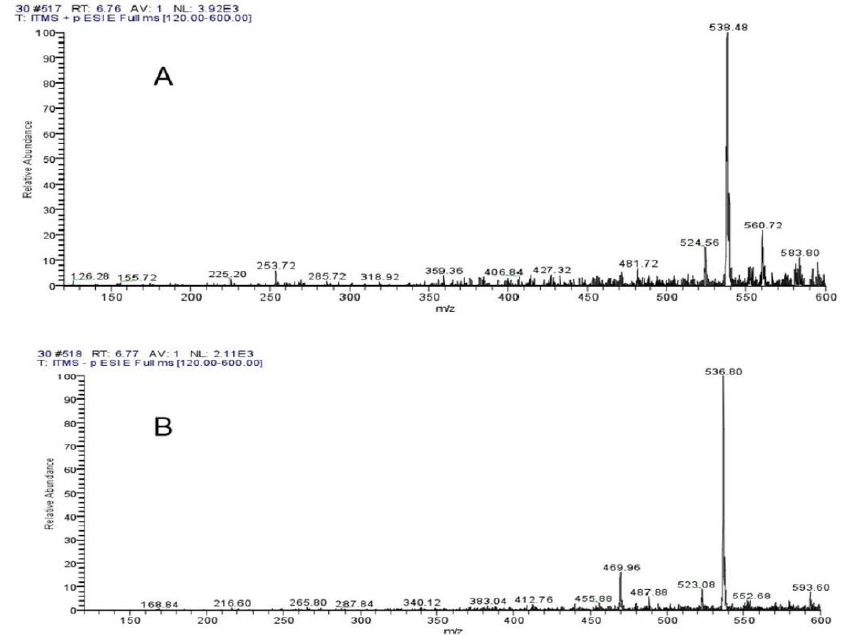
Figure 8. Mass Spectrogram analysis showed ( A ) 538.48 positive ions and ( B ) 536.80 negative ions at 6.20 min.